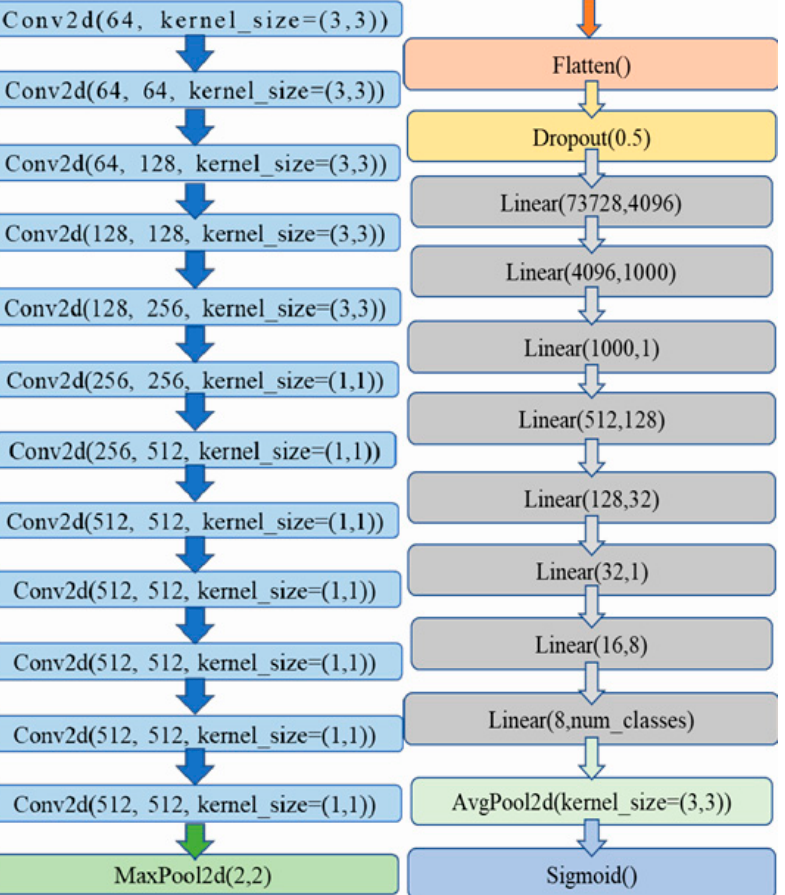
Figure 4. The generic CNN model was used for this investigation.